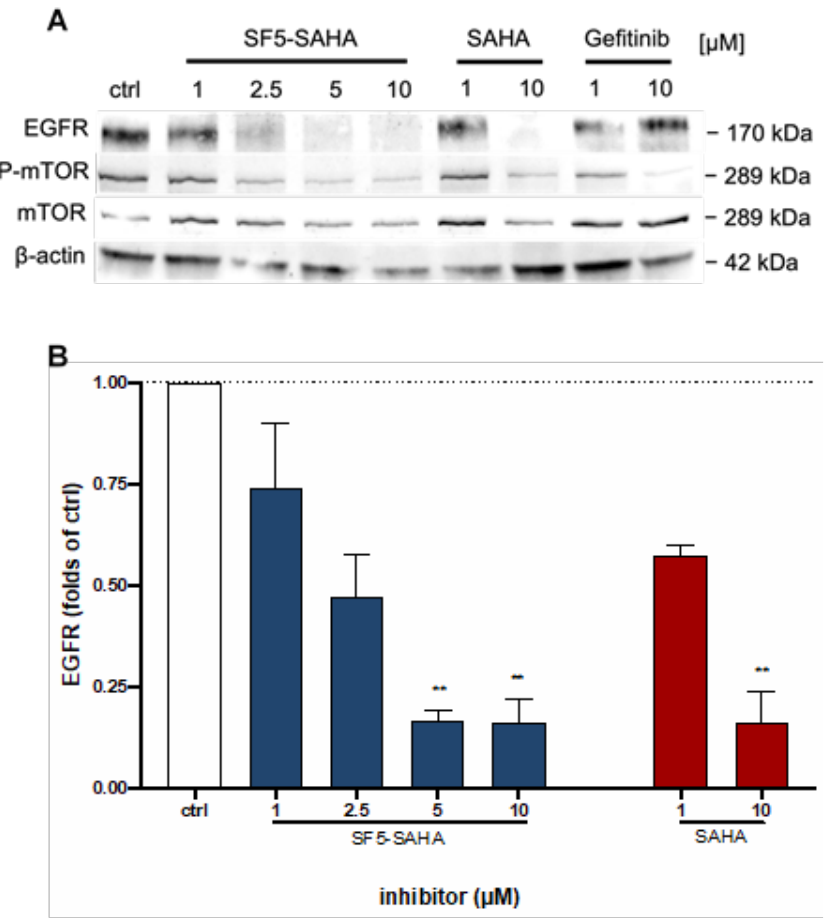
Figure 10. Inhibitory effects of SF5-SAHA on EGFR signaling pathway protein expression. ( A ) Rep- resentative Western blots of n = 3 independent experiments showing treatment induced changes in the expression of EGFR in DU145 cells after 24 h. β -actin was used as loading control. ( B ) From these Western blots gray intensity, mean ± SEM, of EGFRs specific bands were quantified and adjusted to protein loading and normalized to untreated control. ** p ≤ 0.005; 2 -way ANOVA Dunnett ’ s post- hoc test.